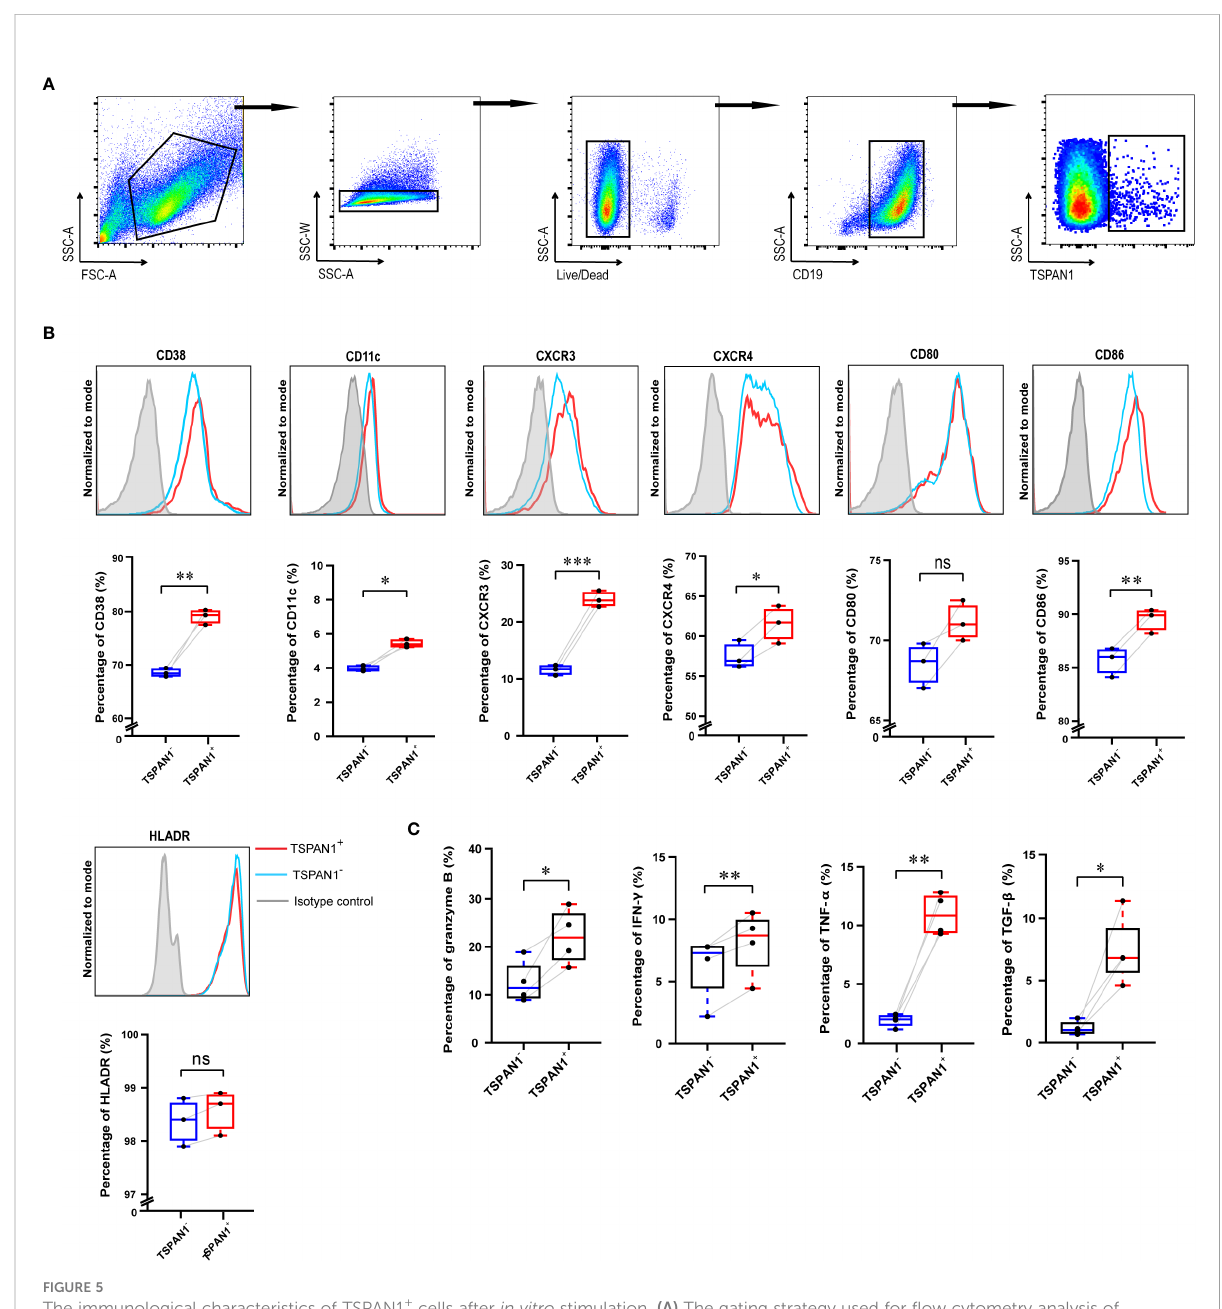
FIGURE 5 The immunological characteristics of TSPAN1 + cells after in vitro stimulation. (A) The gating strategy used for fl ow cytometry analysis of TSPAN1 + cells. (B) Histogram plot of surface markers of TSPAN1 + B cells and paired TSPAN1 - B cells (top row). Measurement of certain surface markers in paired TSPAN1 - cells and TSPAN1 + CD19 + cells were shown (bottom row). (C) The expression level of cytokines in paired TSPAN1 - cells and TSPAN1 + CD19 + cells. Paired Student t -test was used. * P < 0.05, ** P < 0.01, *** P < 0.001, ns: no signi fi